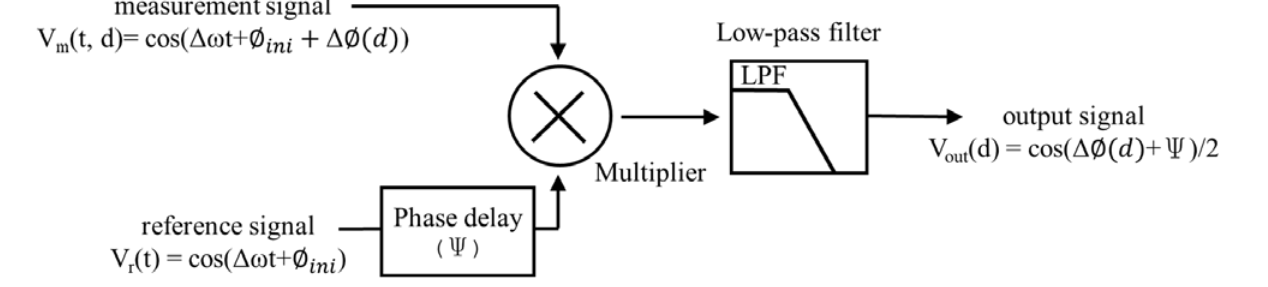
Figure 4. Block diagram of the LIA.